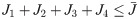
Synaptic weight configurations.a) Two example configurations of K = 4 synaptic weights with J1+J2+J3+J4≤J¯. b) Two examples of K = 5 synaptic weights with sum bounded by J¯.